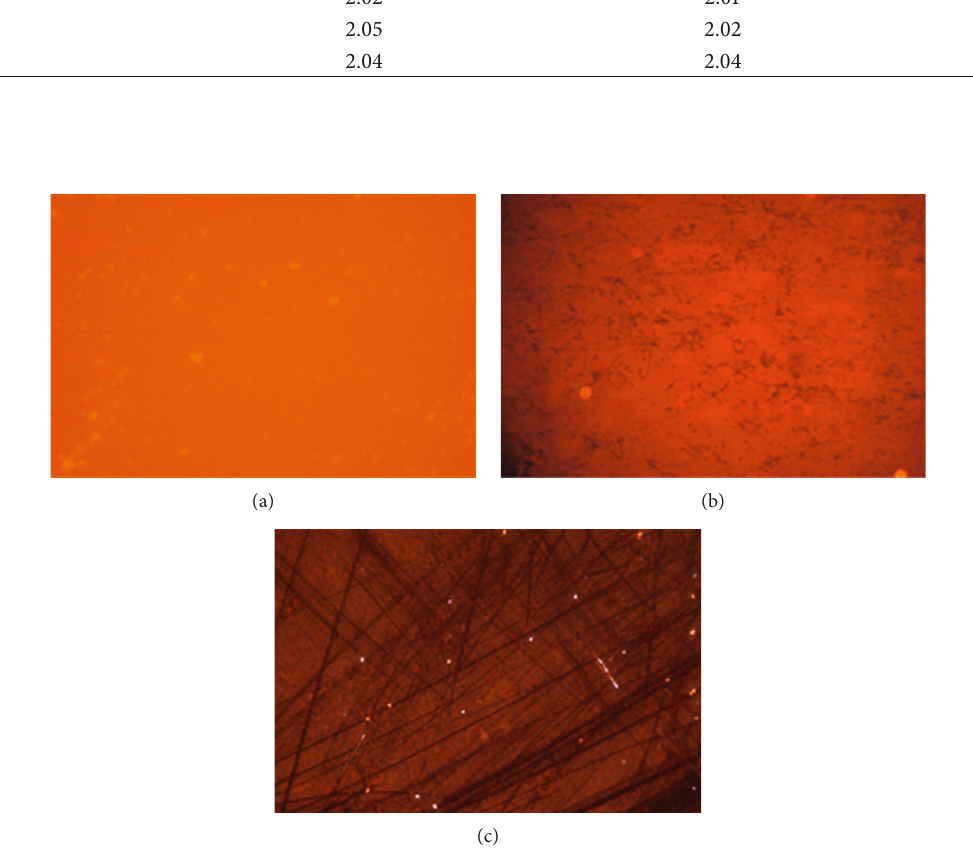
Figure 10: Optical micrographs of InSe thin films with different thickness ratios: (a) 25:75, (b) 50:50, and (c)